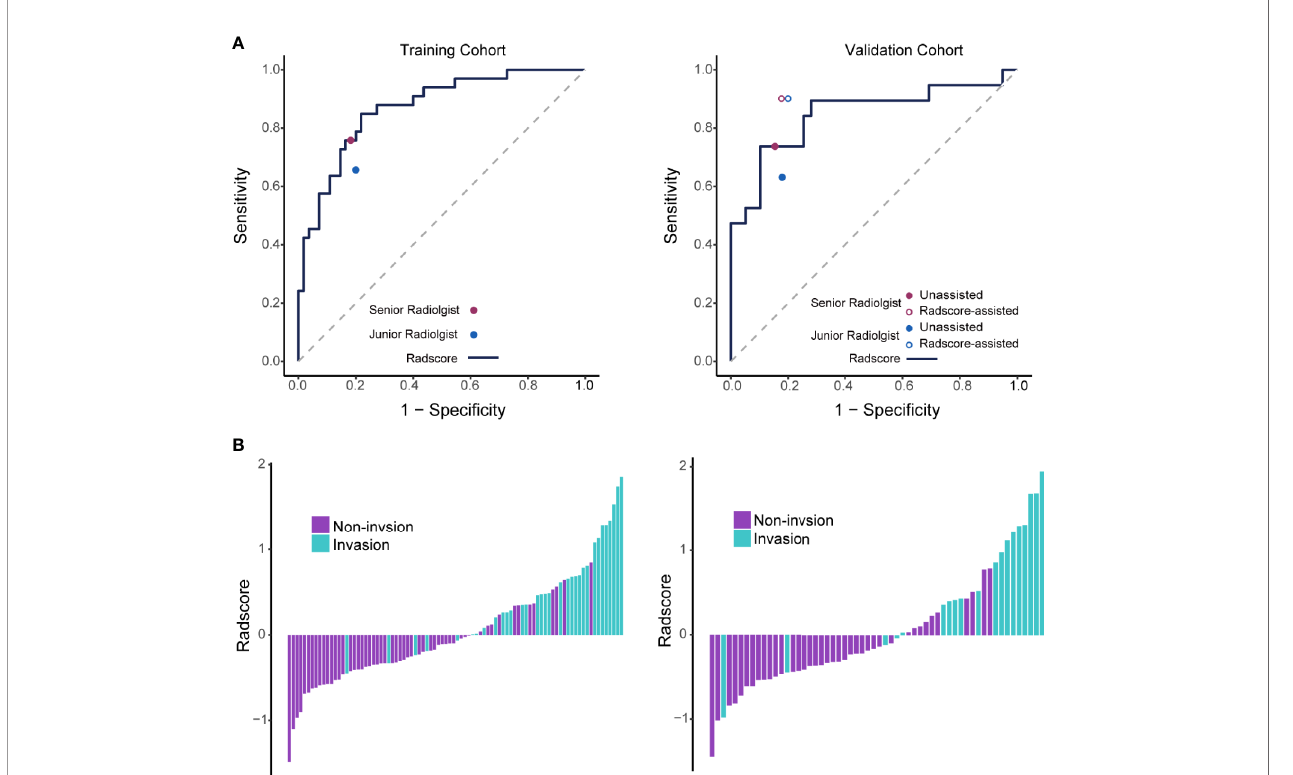
FIGURE 3 | Performance of the radiomics signature with operating points of unassisted and assisted radiologists and the value of Radscores per patient. (A) ROC curves of the radiomics signature in the training and validation cohorts. Individual unassisted radiologist (speci fi city, sensitivity) points are also plotted, where the purple point represents unassisted senior radiologist, and the blue points represents unassisted junior radiologist. In the validation cohort, individual assisted radiologist (speci fi city, sensitivity) points are also plotted, where the purple circle represents Radscore-assisted senior radiologist, and the blue circle represents